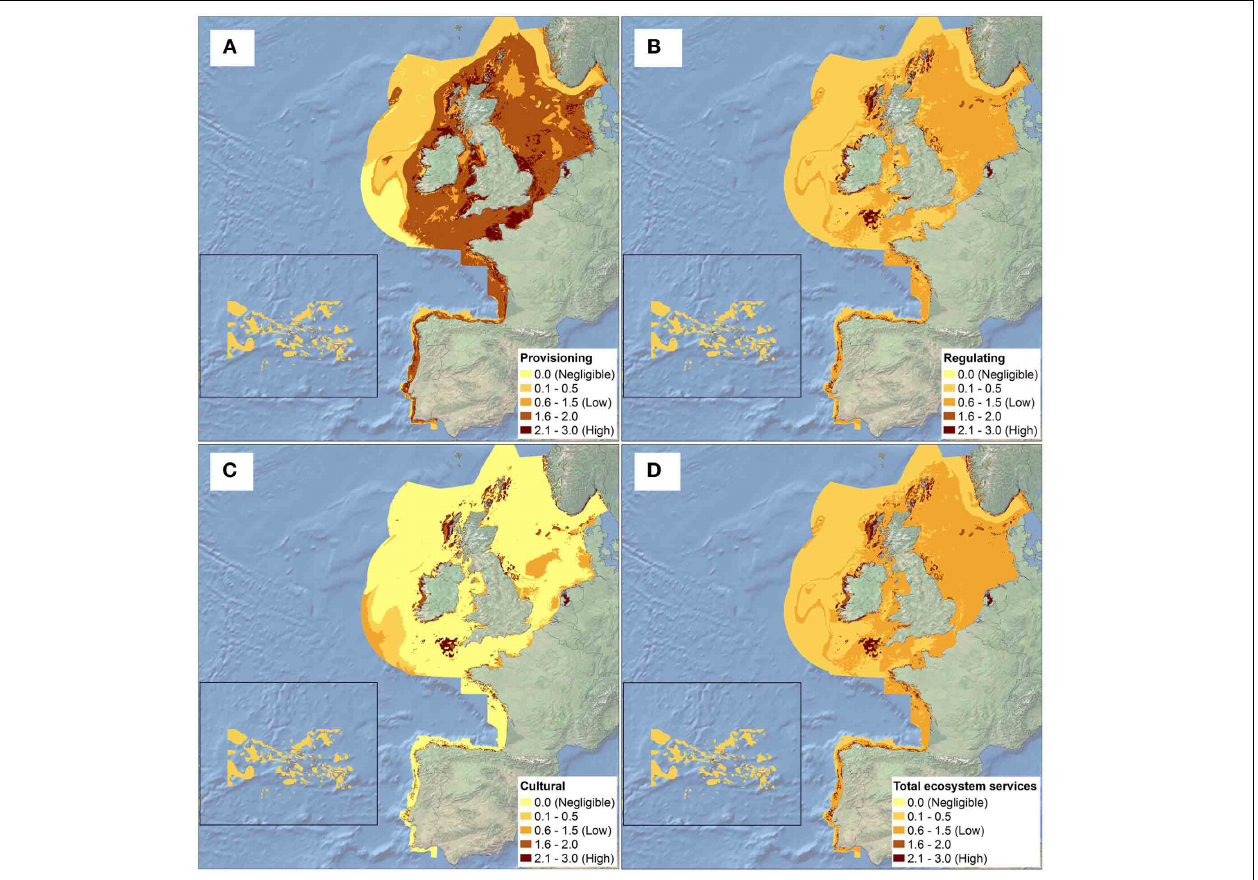
FIGURE 5 | Spatial distribution of the mean value of aggregated ecosystem: (A) Provisioning services; (B) Regulating services; (C) Cultural services; and (D) Total ecosystem services.